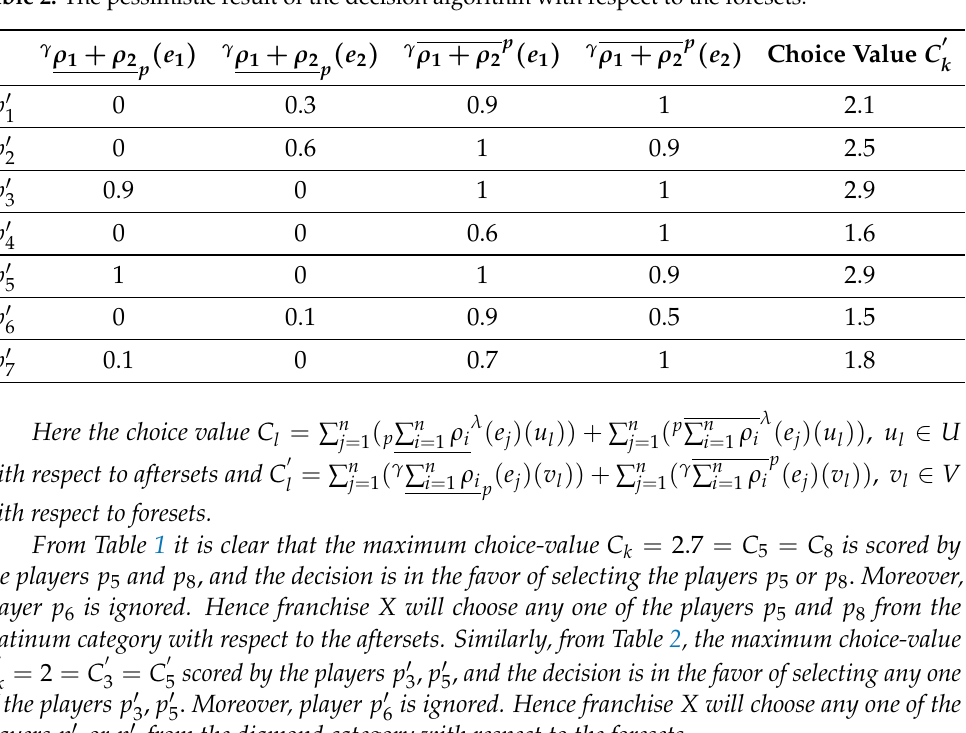
Table 2. The pessimistic result of the decision algorithm with respect to the